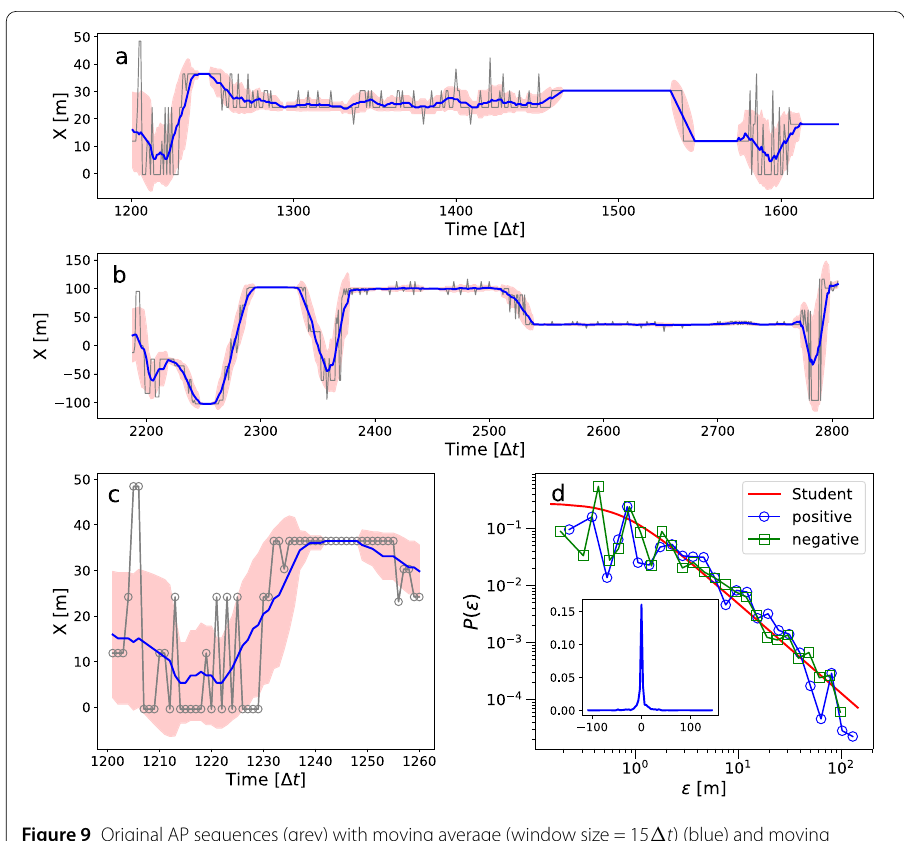
Inset: distribution of the noise terms on linear scales